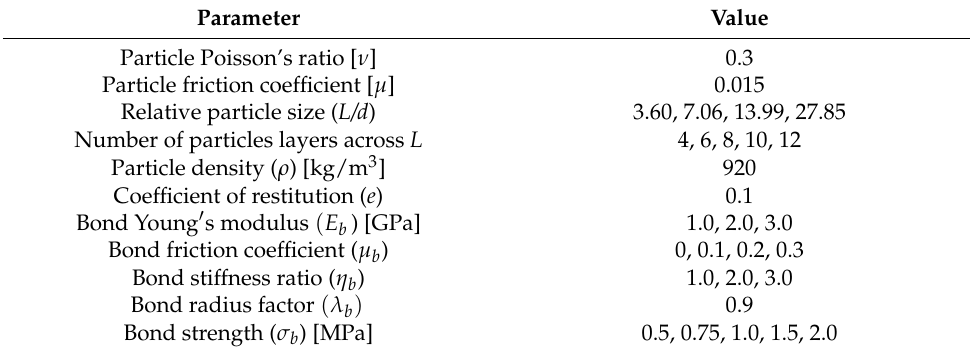
Table 1. Summary of simulation parameters.